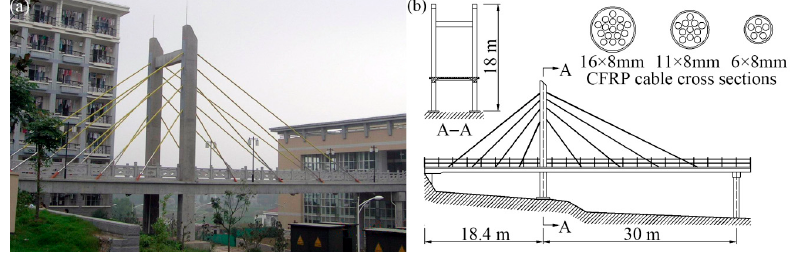
Figure 17. Jiangsu University CFRP Footbridge, ( a ) photo (photo credit: Kuihua Mei) and ( b ) sketch.